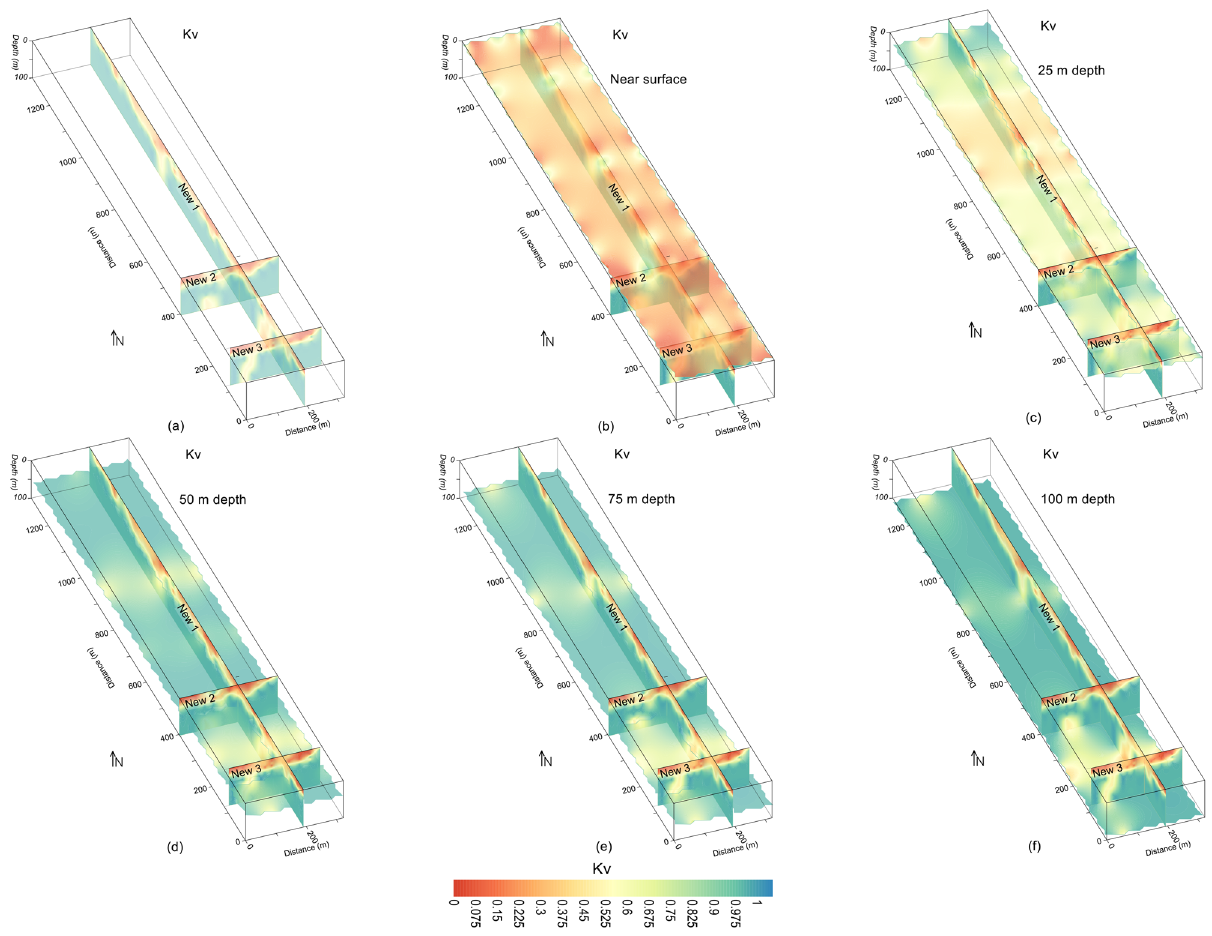
Figure 9. Kv imaging (increasing from red to blue on a color scale) for: ( a ) the integration of three Kv profiles, ( b ) ground surface including ( a ); ( c ) 25 m depth including ( a ); ( d ) 50 m depth including ( a ); ( e ) 75 m depth including ( a ); and ( f ) 100 m depth (bottom) including ( a